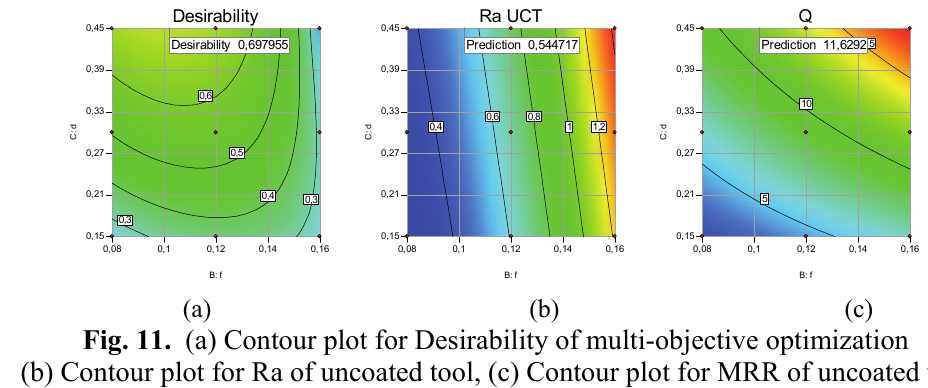
Fig.10. (a) Contour plot for Desirability of multi-objective optimization (b) Contour plot for Ra of uncoated tool, (c) Contour plot for MRR of uncoated tool, while (d) kept at the optimal value